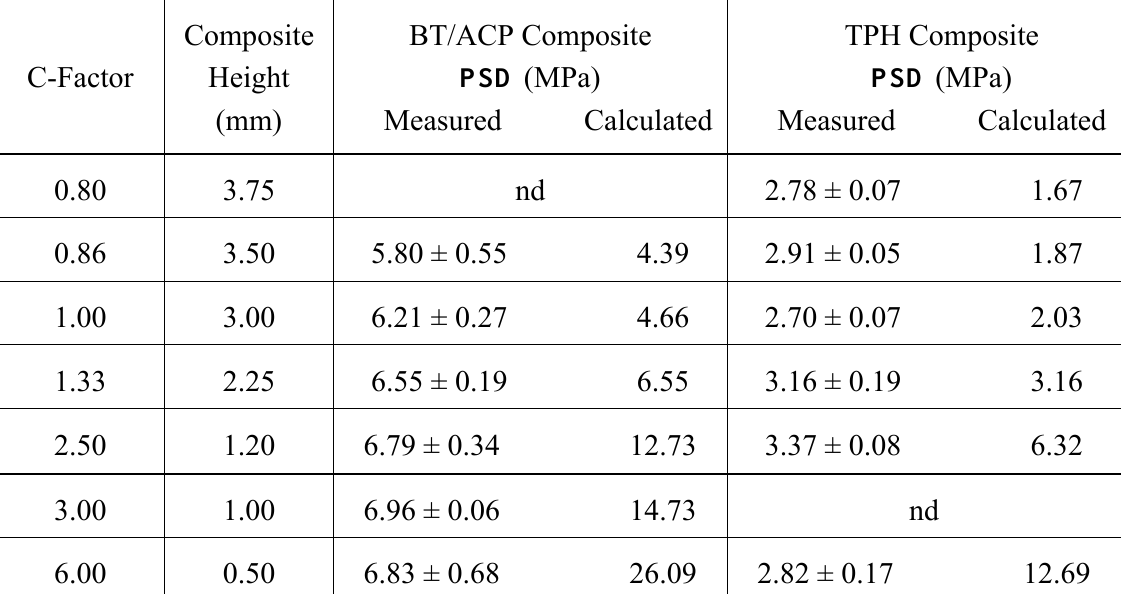
Table 1. Measured PSD (mean value ± SD of three repetitive measurements) and the corresponding calculated PSD for BT/ACP and TPH composites as a function of